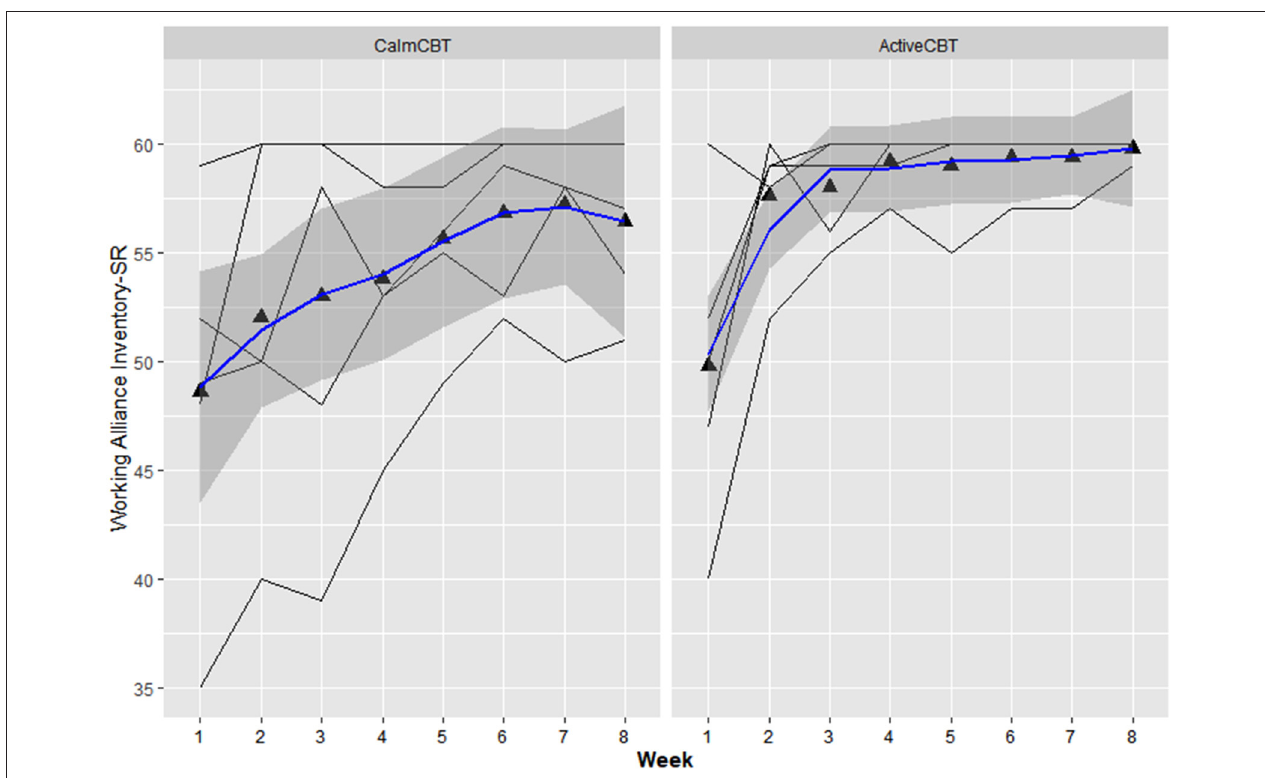
FIGURE 4 | Working alliance inventory short revised (WAI-SR) by group over time. Data are total scores of the Working Alliance Inventory (range 15–60) administered at the end of each CBT session. High scores indicate a stronger therapeutic